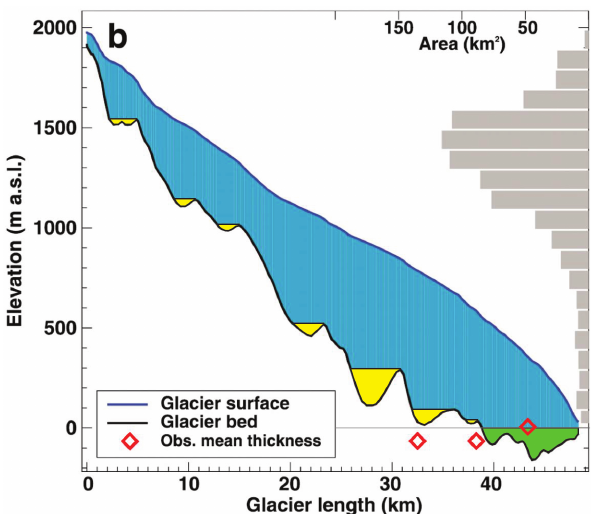
Fig. 3. Long profile of Taku Glacier adapted from Huss and Farinotti (2012; their Fig. 3). Ice in overdeepened bed parts and sites of potential lake formation are marked with yellow, ice below sea level with